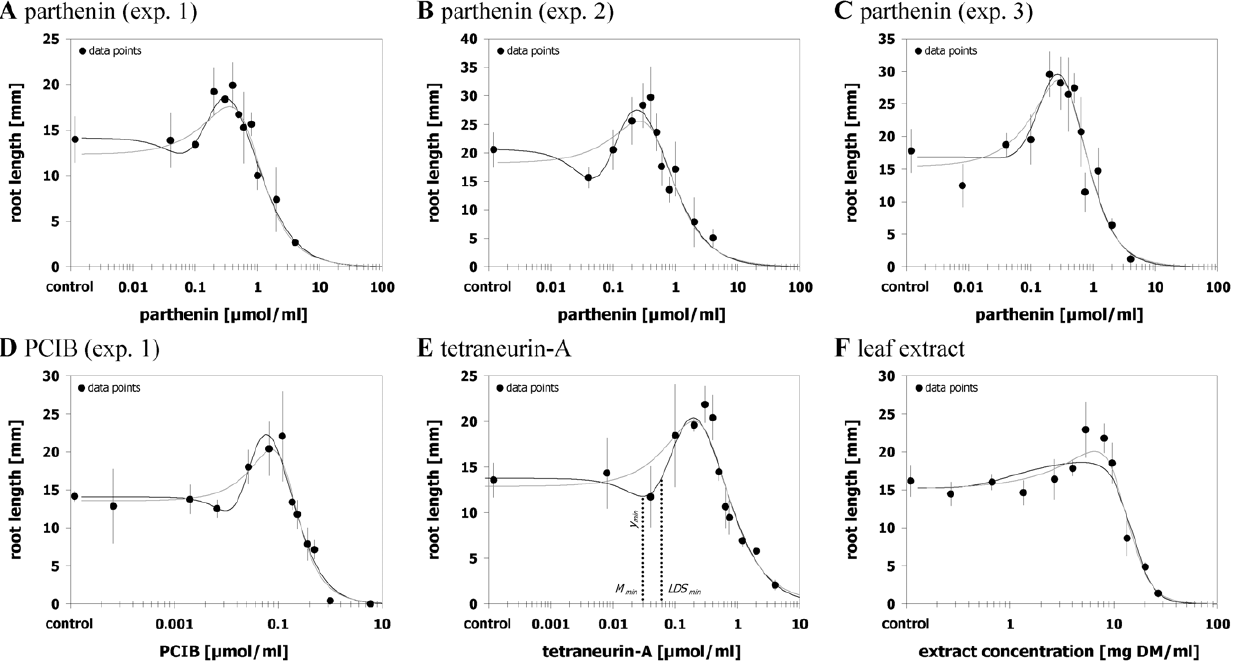
Figure 2. Brain and Cousens model more suitable. Dose-response relationships for effects of different phytotoxins and an aqueous leaf extract of Parthenium hysterophorus at the flowering stage on root growth of Lactuca sativa and their description by the hormetic dose-response models after Brain and Cousens [9] (grey curve) or Cedergreen et al. [2] (black curve). The Cedergreen et al. model [2] did not detect significant hormetic responses ( f , 0) (A–E) or provided an inferior fit (F). Error bars represent standard deviation. DM=dry leaf